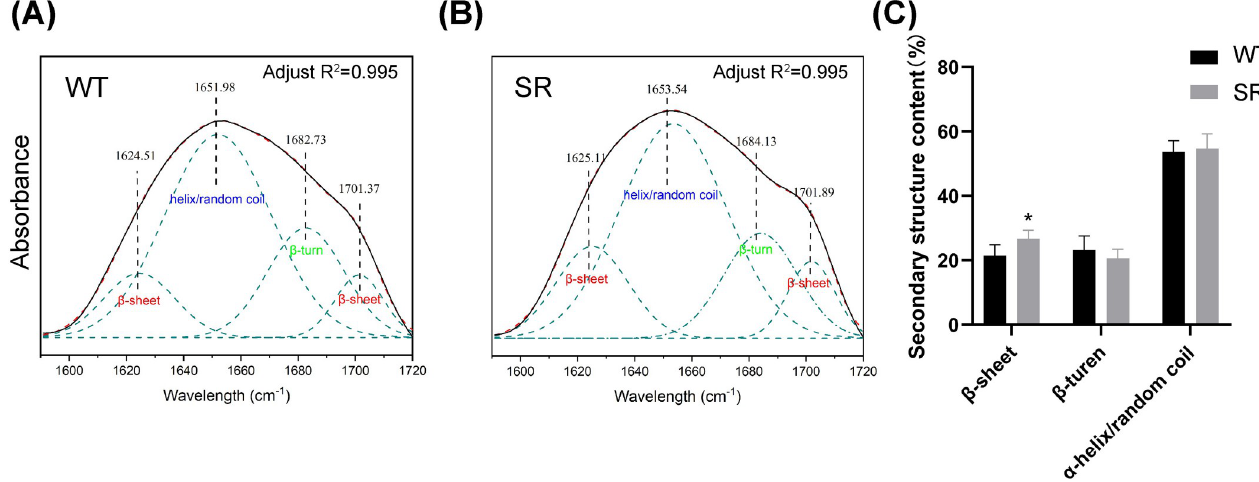
Fig 4. Characterization of secondary structure of transgenic silk. (A, B) Deconvolution of the corresponding amide I band of the WT. (C) Secondary structure content of the control and SR. The mean ± SD derived from three independent replicate experiments. � represent p < 0.05, (Two-tailed unpaired t-